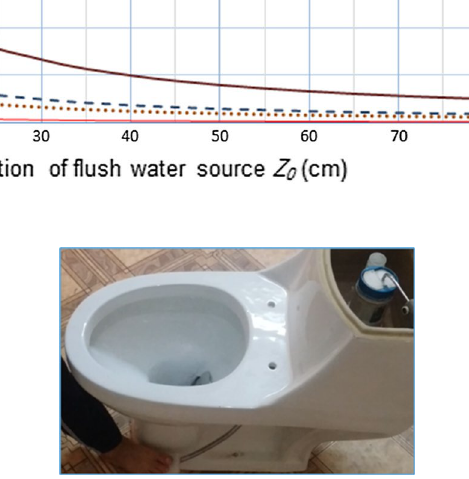
Fig. 4 Application of bowl-rotatable blade on a ceramic